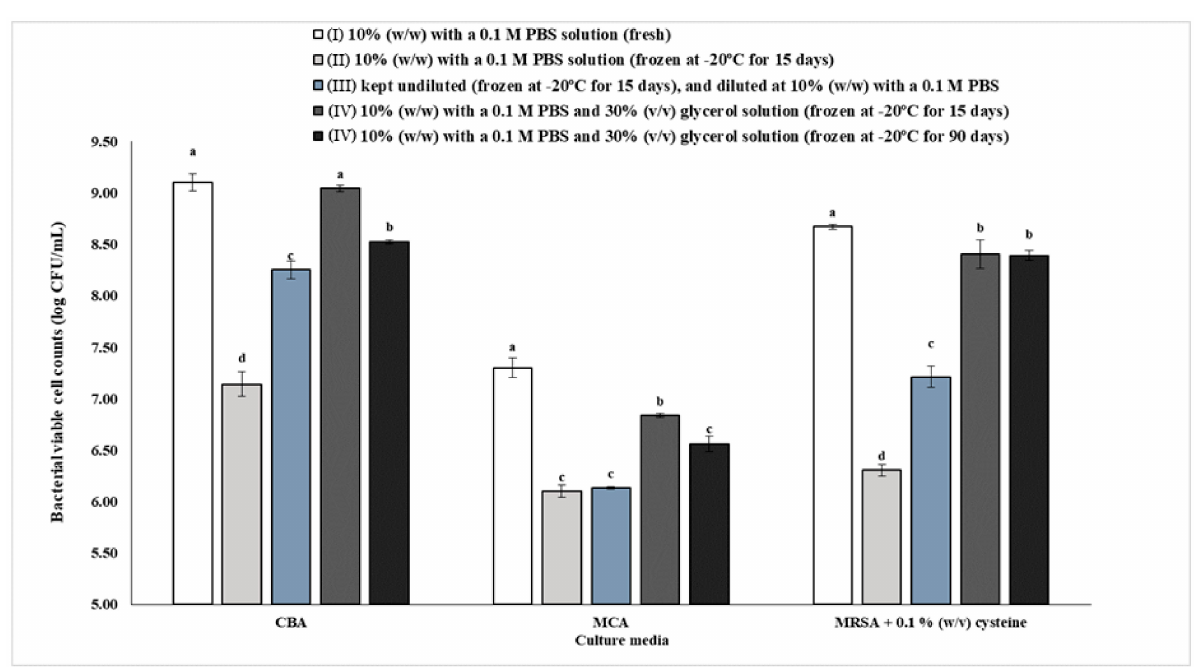
Figure 4. Bacterial viable cell counts (log CFU/mL, mean ± SD) of the inoculum mixed at 10% (w/w) with a 0.1 M PBS solution and analyzed fresh (I) or frozen at − 20 ◦ C for 15 days (II), kept undiluted and also frozen at − 20 ◦ C for 15 days and later diluted at 10% ( w / w ) with 0.1 M PBS (III), 0.1 M PBS, and 30% ( v / v ) glycerol solution, and frozen for 15 to 90 days (IV), obtained using different culture media incubated fo 72 h at 37 ◦ C in anaerobic conditions. Different letters mark statically significant ( p < 0.05) differences between each condition when plated in each culture